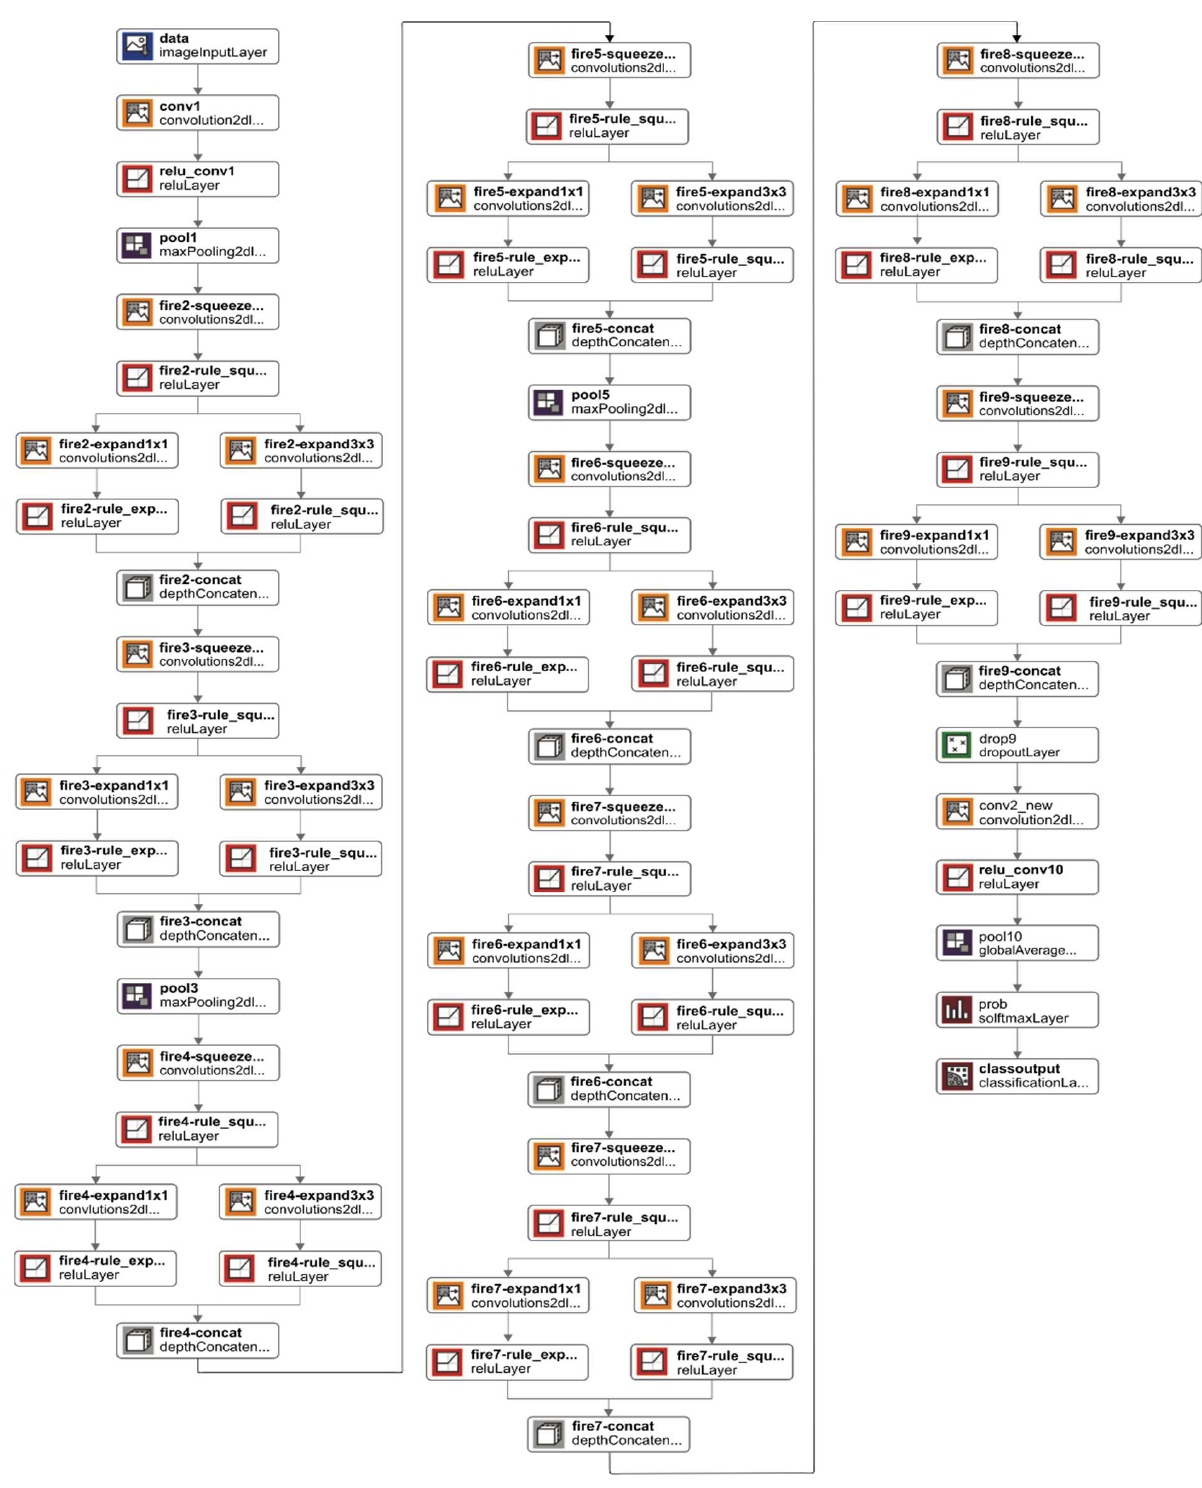
Figure 6. SqueezeNet used in this study: all layers are connected.